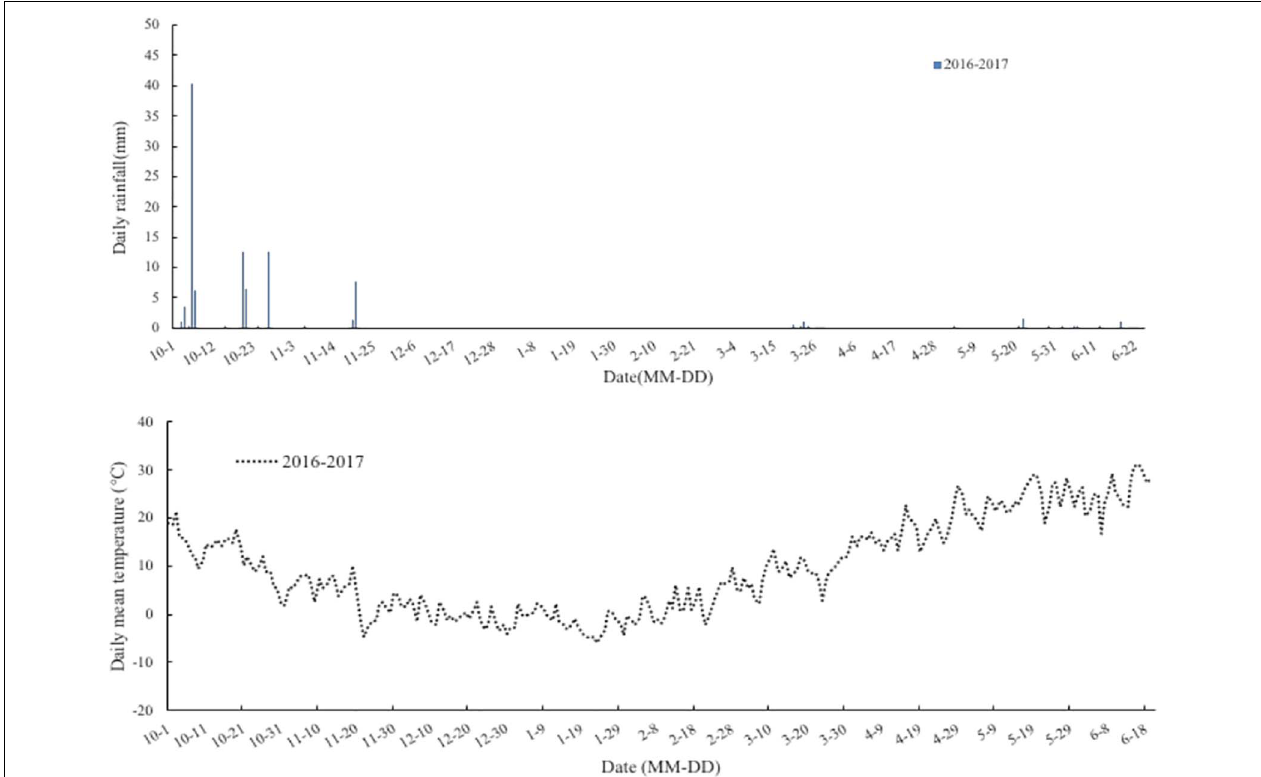
FIGURE 1 | Rainfall (mm) and daily temperature ( ◦ C) at the wheat-maize rotation CAAS-FACE system in Changping, Beijing, China, from sowing of winter wheat until maturity during 2016–2017 experiment years.